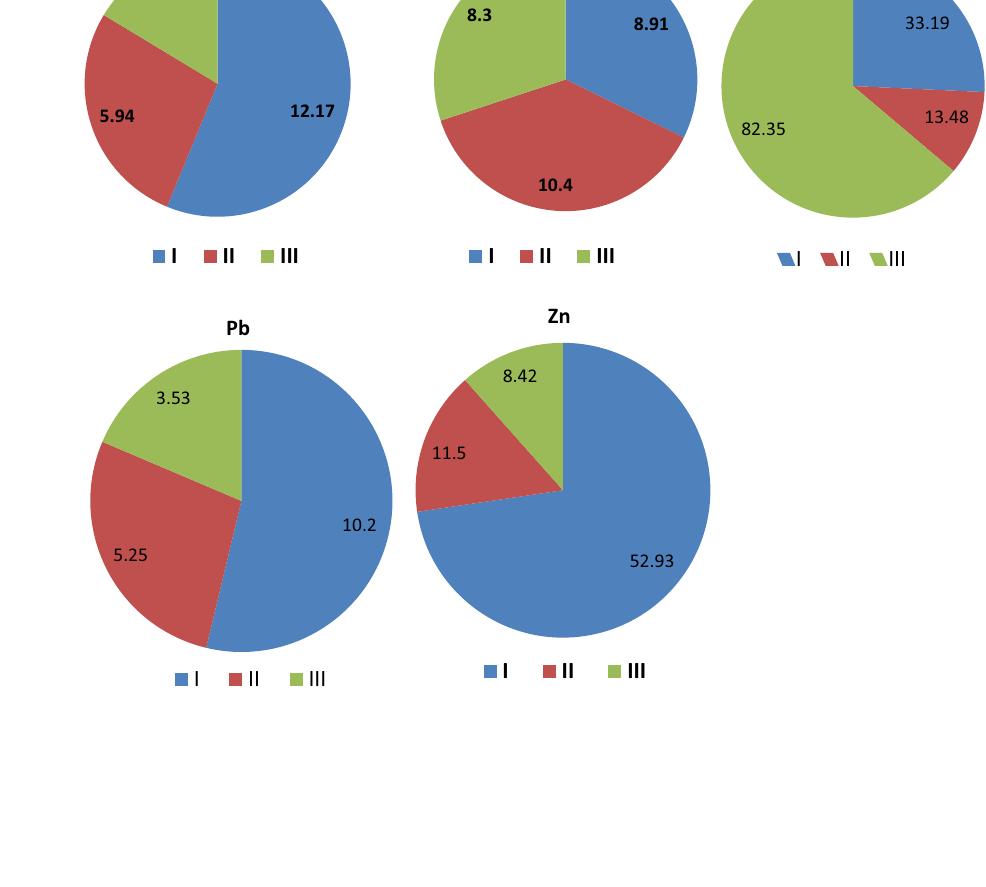
Fig. 7 Water Pollution Index of the measured metals in water collected from investigated area.